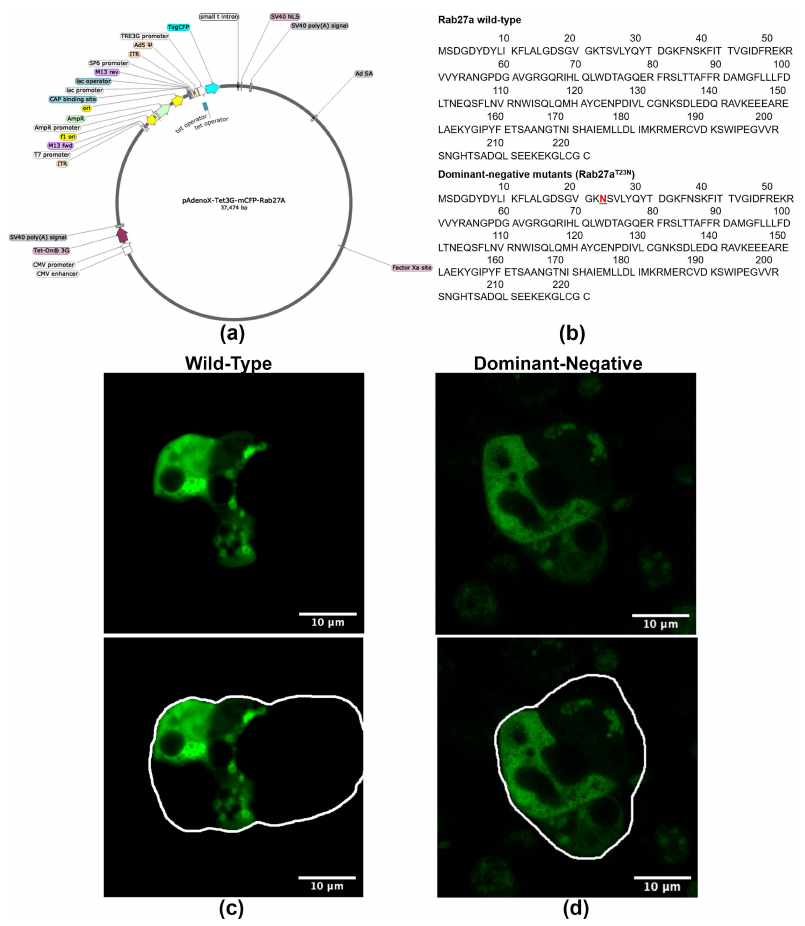
Figure 3. WT and DN Ad-mCFP-Rab27a constructs and characterization. ( a ) Tet-on WT and DN Ad-mCFP-Rab27a vectors were generated by subcloning the mCFP-Rab27a inserts into the in-fusion cloning site of linearized pAdenoX-Tet-3G vector and packaged in 293a cells. ( b ) Amino acid sequences of WT Rab27a and DN Rab27a T23N , red indicates the sequence location of dominant negative mutation. ( c ) WT Ad-mCFP-Rab27a was transduced into primary rabbit LGACs ( d ) DN Ad-mCFP-Rab27a was transduced into primary rabbit LGACs. In ( c , d ), mCFP was directly imaged with a 458 nm laser. Transduced cells expressing mCFP-Rab27a (green) are outlined in white to delineate the multicellular acinar